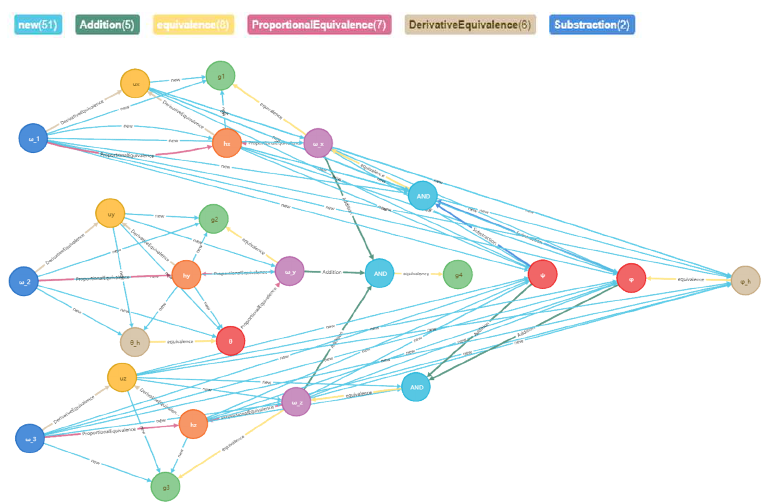
Figure 8. Completed performance-fault relationship graph of spacecraft control system.